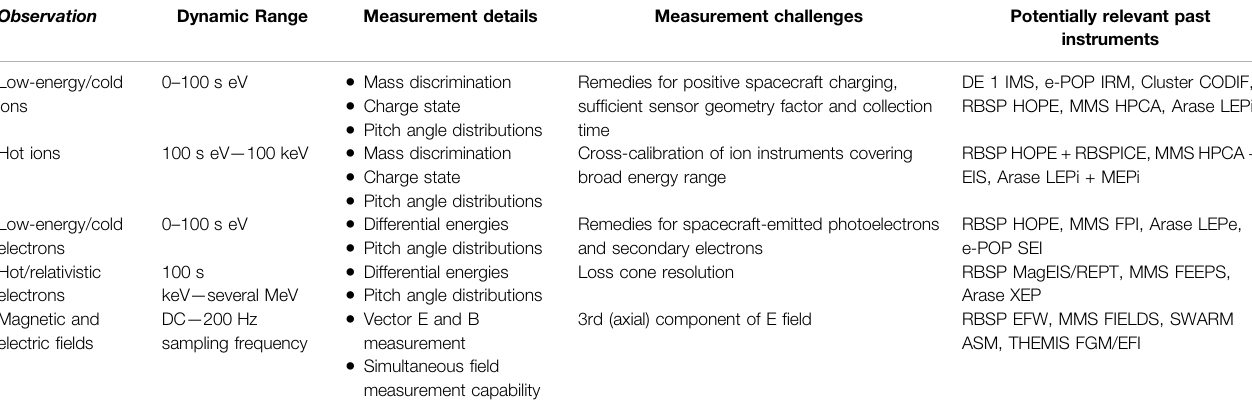
TABLE 1 | Summary of relevant desired particle and fi eld observations for future EMIC wave studies, including instrument challenges for making these